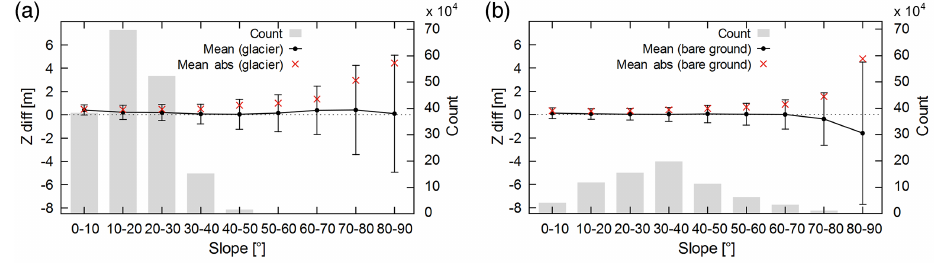
Figure 8. Mean, mean of the absolute values and standard deviation of the 2014 DoD between SfM–MVS and ALS-based DEM depending on slope calculated (a) inside the glacier area and (b) in the bare ground outside glacier covered by rock. The grey bars show the count of cells at any given slope ( y axis on the right).